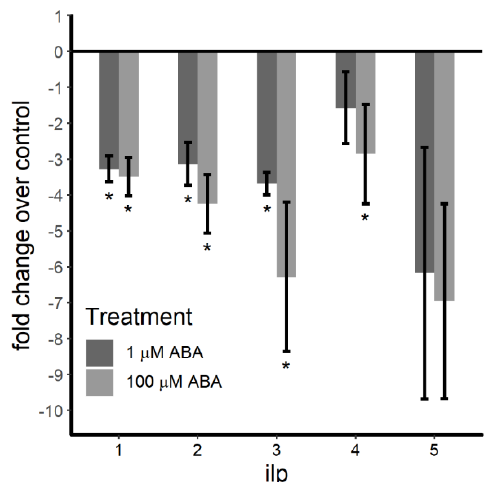
Figure 5. Insulin-like peptide ( ilp ) expression levels in 3-day-old female A. stephensi derived from ABA-treated larvae were reduced relative to females derived from control larvae. Transcript levels were quantified by qRT-PCR using the log 2 (2 – ∆∆ Ct ) method; untreated controls (0 µ M ABA) were set to 0. Transcript levels were reduced for ilp1 ( F = 18.83, p = 0.003), ilp2 ( F = 9.02, p = 0.012), ilp3 ( F = 60.92, p < 0.001) and ilp4 ( F = 4.26, p = 0.05). Compared to controls, expression levels for ilp1 ( p = 0.003), ilp2 ( p = 0.035) and ilp3 ( p < 0.001) were significantly reduced in mosquitoes derived from 1 µ M ABA-treated larvae. In females derived from 100 µ M ABA-treated larvae, transcript levels were reduced relative to controls for ilp1 ( p = 0.006), ilp2 ( p = 0.012), ilp3 ( p < 0.001) and ilp4 ( p = 0.047). However, transcript levels for ilp5 were not significantly reduced relative to control in either group of females derived from ABA-treated larvae ( F = 0.259, p = 0.774). Data were analyzed by ANOVA and are shown as mean ± SE for three biological replicates with separate cohorts of A. stephensi . * p ≤ 0.05.